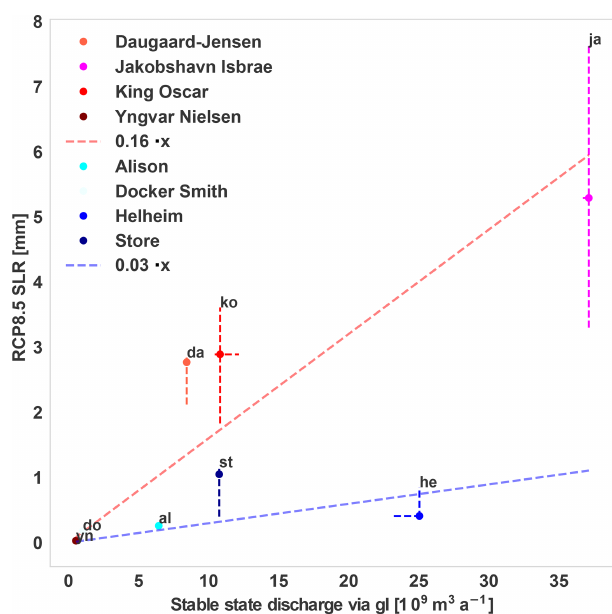
Figure 13. First to third quartiles (median indicated with a dot) of contribution to SLR under RCP8.5 for eight glaciers from Ta- ble 3 as a function of the present-day grounding line discharge. The future simulations were forced by changes in SMB, subglacial discharge, and minimal and maximal ocean temperature trend (Ta- ble 1). Dashed lines indicate a linear function of the present-day grounding line discharge in future SLR for 2100 obtained with an ordinary least-square model from the median values for four glaciers only that result in a high slope (reddish colors) and that result in a low slope (blueish colors). For the reddish glaciers, the resulting slope and p value are 0 . 03mmkm − 3 yr and 0 . 18, respec- tively, and for the blueish glaciers 0 . 16km − 3 yr and 0 .